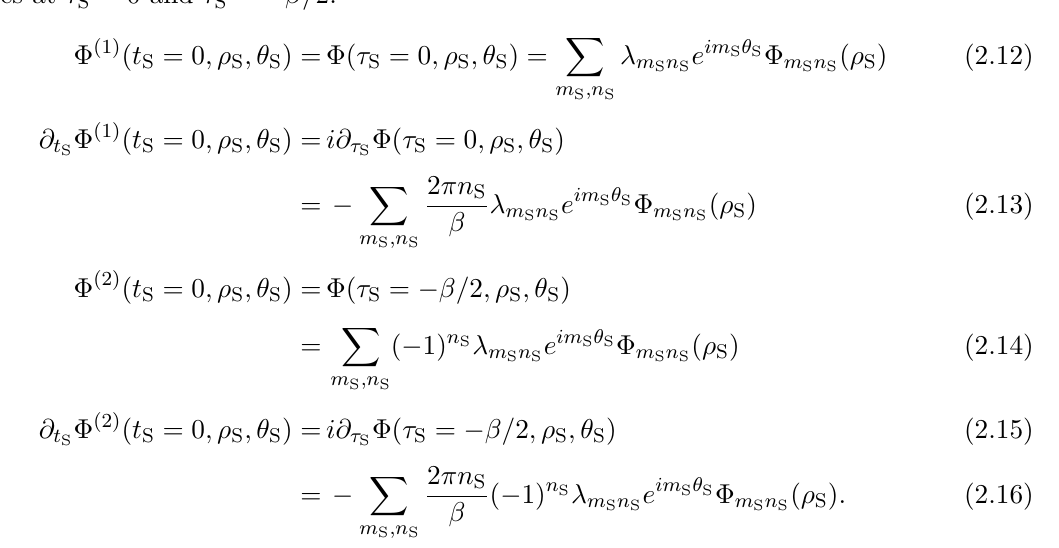
Figure 3. (cid:8) 0 n plotted against (cid:26) S and (cid:27) S for n S = 0 ; 1 ; : : : ; 10 (coloured) and n S = 25 ; 50 ; 100 S (black). The upper-most and bottom-most coloured curves are for n S = 0 ; 10 respectively and the black dotted, dashed, and solid curves are for n S = 25 ; 50 ; 100 respectively. Here, (cid:23) = 1 = 2. The radial dependence of the various m = 0 modes (cid:8) of the (cid:12)eld are plotted in 0 n S S (cid:12)gure 3(a) as functions of (cid:26) . In (cid:12)gure 3(b), we also plot (cid:8) as a function of an alternative 0 n S S radial coordinate (cid:27) , given by (B.9), which will be useful later. S The initial data for the two sides of the black hole can be read o(cid:11) from (2.10) on the slices at (cid:28) = 0 and (cid:28) = (cid:0) (cid:12)= S S